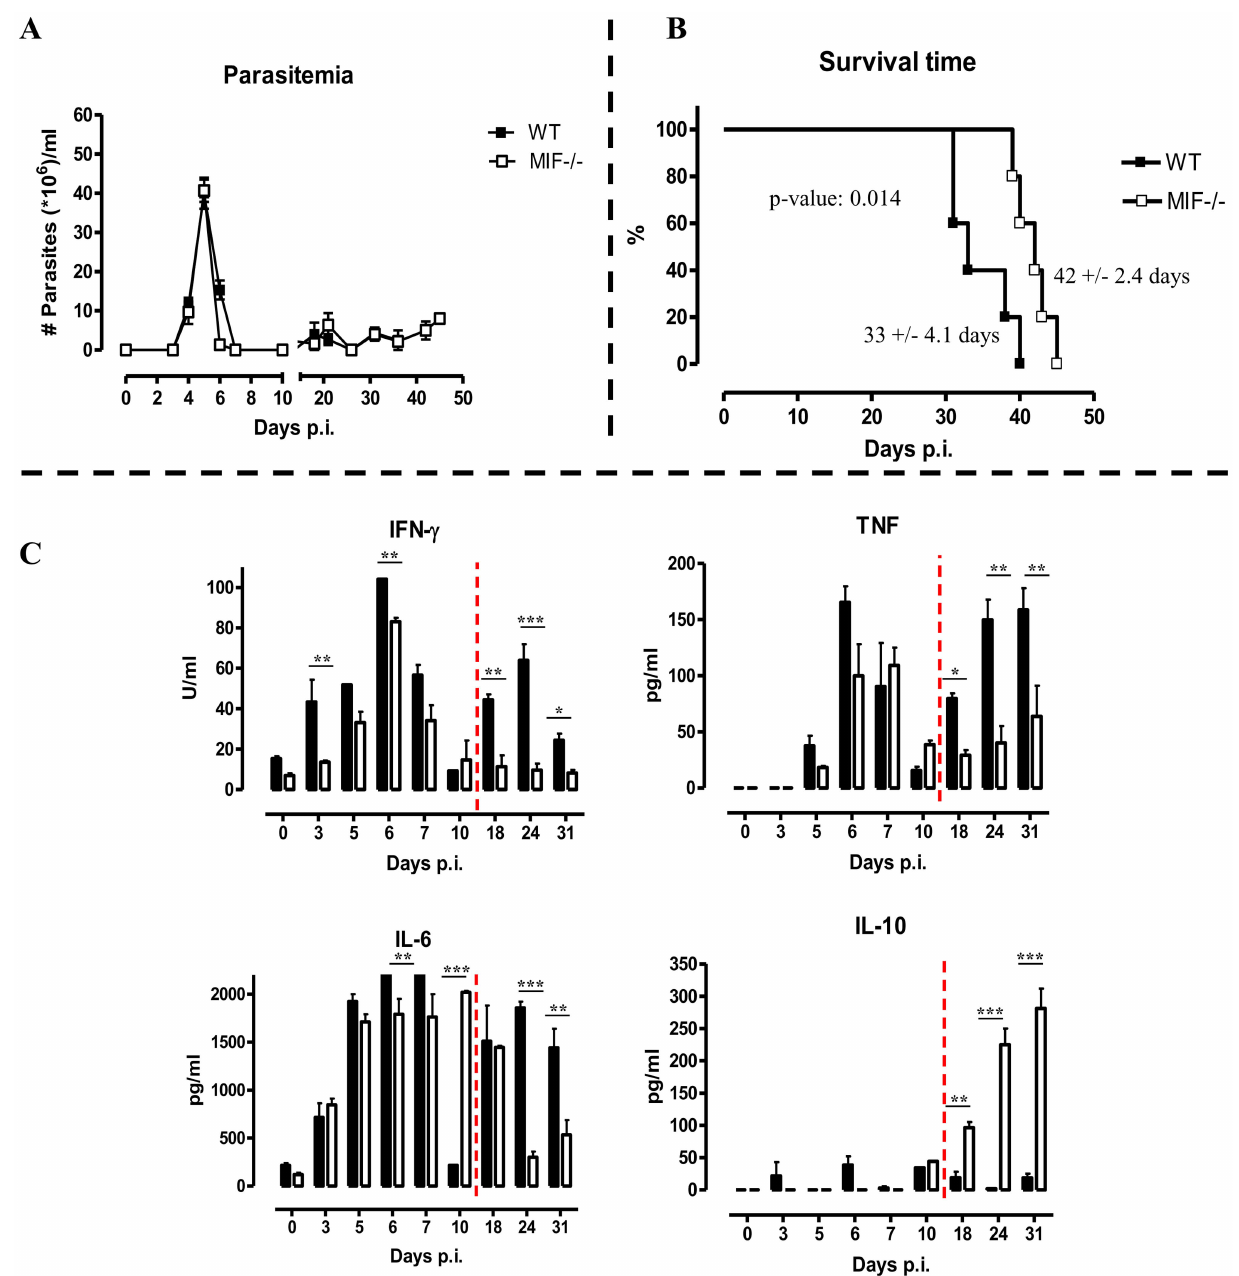
Figure 2. MIF deficiency confers protection and reduces inflammatory immune responses during T.brucei infection. Parasitemia (A) and survival (B) during infection in C57Bl/6 (WT, black box; Mif 2 / 2 , white box) Mice. Results are representative of 2–5 independent experiments and expressed as mean of 5 individual mice 6 SEM. (C) Serum cytokine levels of IFN- c (upper left panel) (1 U=100 pg), TNF (upper right panel), IL-6 (lower left panel) and IL-10 (lower right panel) in Mif 2 / 2 (white bars) and WT (black bars) mice. The dashed line delineates the transition from the acute to the chronic phase of infection. Results are representative of 3 independent experiments and presented as mean of 3 individual mice 6 SEM (*: p- values # 0.05, **: p-values # 0.01, p-value: *** #